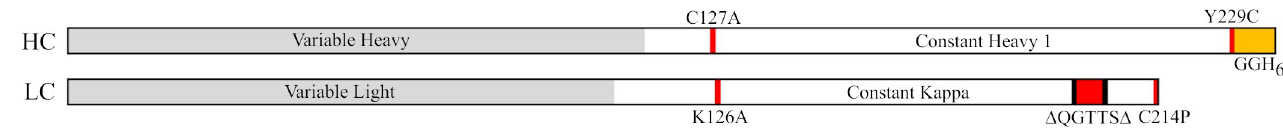
Fig 3. Fab construct design and location of mutations. Depiction of the Fab portion of a HC and LC used for crystallization. Red bars indicate the locations of the various mutations discussed in the text. Black bars indicate the two deleted residues at either end of the FG loop design. Orange indicates the hexahistidine tag.